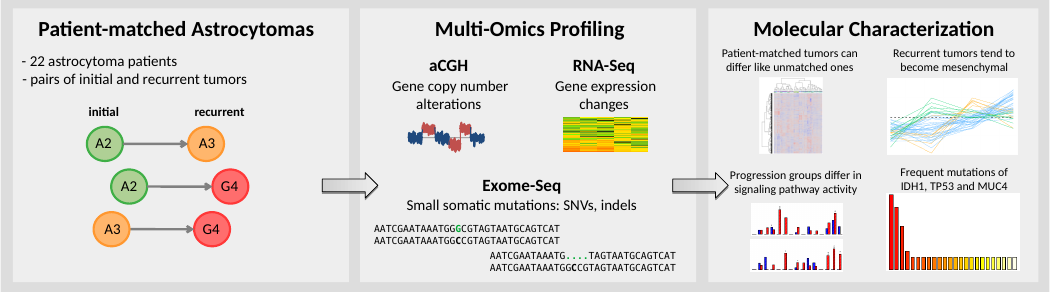
Figure 1. Methodological overview. Left box: A cohort of 22 astrocytoma patients was established to analyze patient-matched pairs of initial and recurrent tumors. Astrocytoma pairs mainly represented patient-specific transitions from diffuse astrocytomas to anaplastic astrocytomas (A2 → A3), from diffuse astrocytomas to secondary glioblastomas (A2 → G4), and from anaplastic astrocytomas to secondary glioblastomas (A3 → G4). Middle box: Comprehensive multi-omics profiling based on array-based comparative genomic hybridization (aCGH), transcriptome sequencing (RNA-Seq), and exome sequencing (Exome-Seq) was performed for the majority of the patient-matched pairs. Right box: Molecular measurements of patient-matched astrocytoma pairs were considered to search for molecular signatures and frequently mutated genes associated with the stage-wise progression of astrocytomas towards secondary